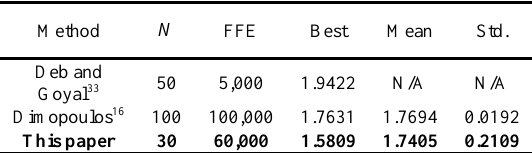
Table 10. Statistical results of different methods for the 2nd variation of welded beam